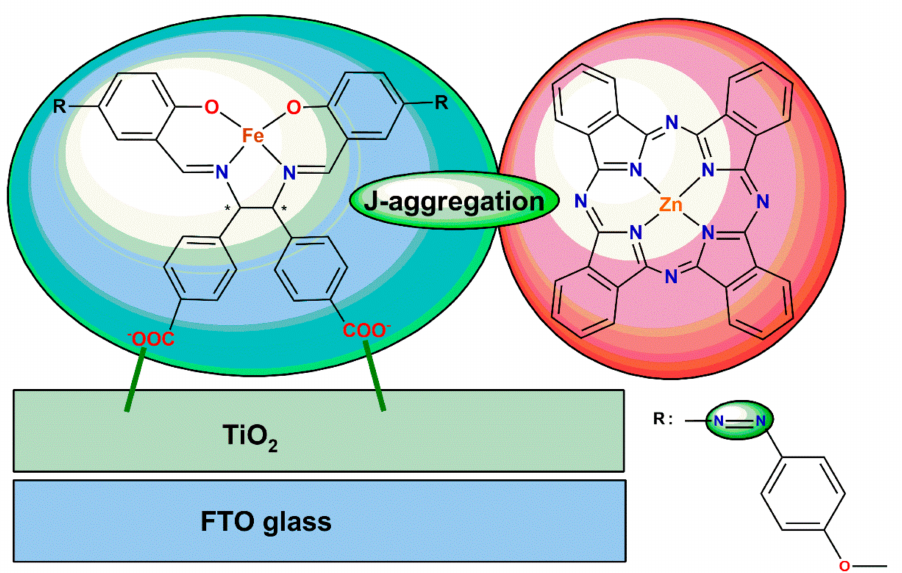
Figure 8. Formation of J-aggregation of Fe(II) and Zn(II) complexes on the surface of TiO 2 (* denotes an asymmetric carbon atom). Adapted with permission from Ref. [47]. Copyright 2022,